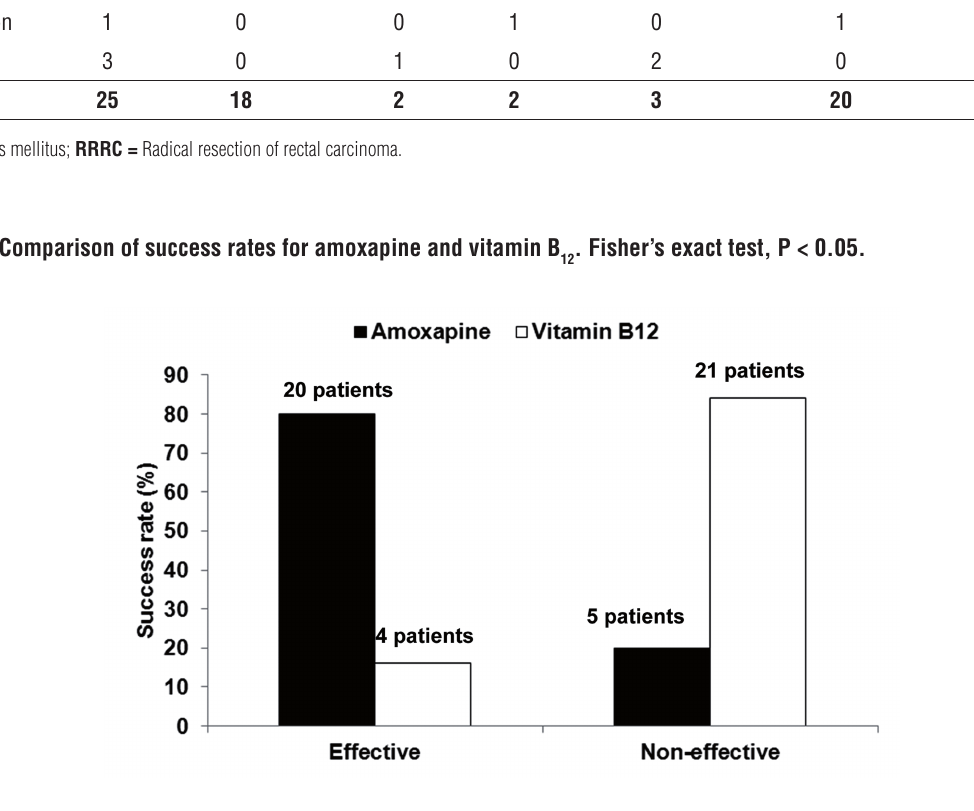
Table 2 - Pharmacologic treatment outcomes. Cause